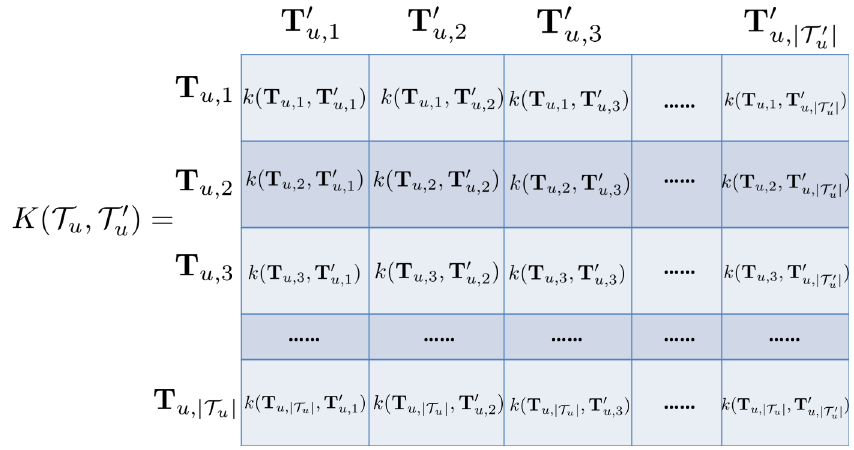
Figure 4. An example of user u ’s covariance matrix K ( T u , T (cid:48) u ) , where k ( . ) is the covariance function that calculates the covariance of the given pair of temporal information vectors. | . | denotes the cardinality of a